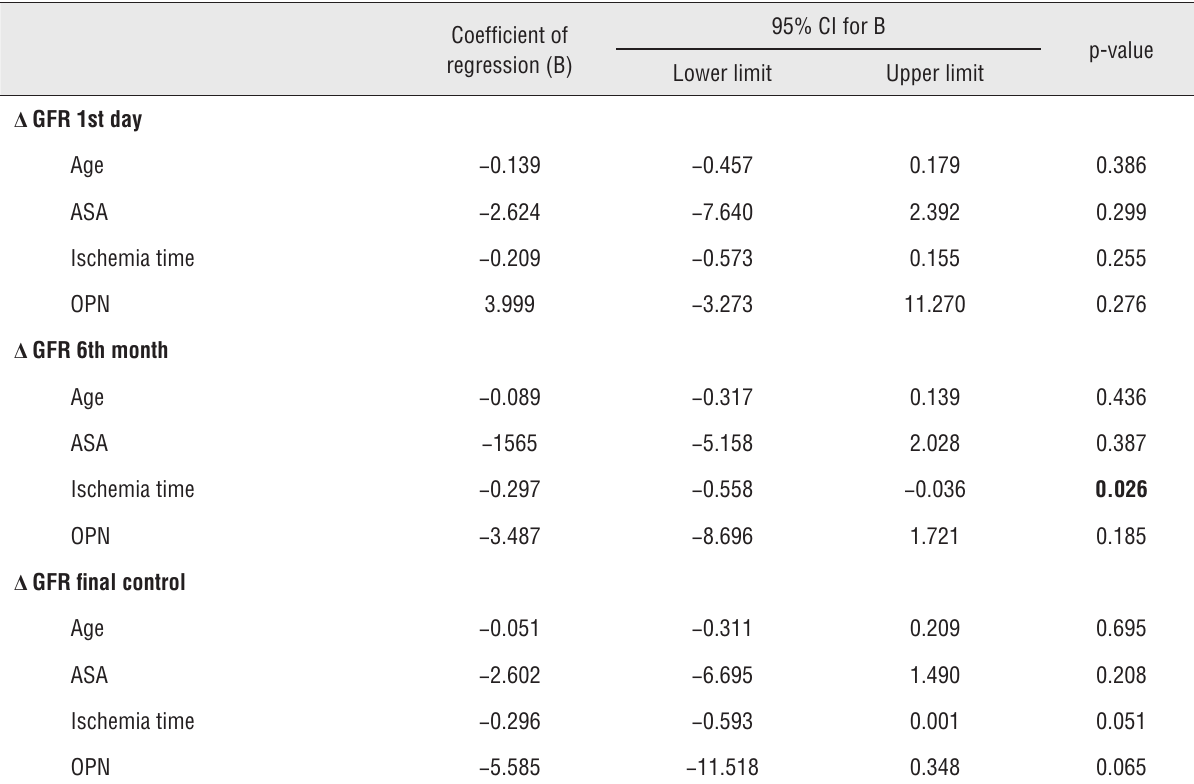
Table 5 - Multivariate linear regression analysis of potential predictive factors, which may affect the decrease in postoperative MDRD